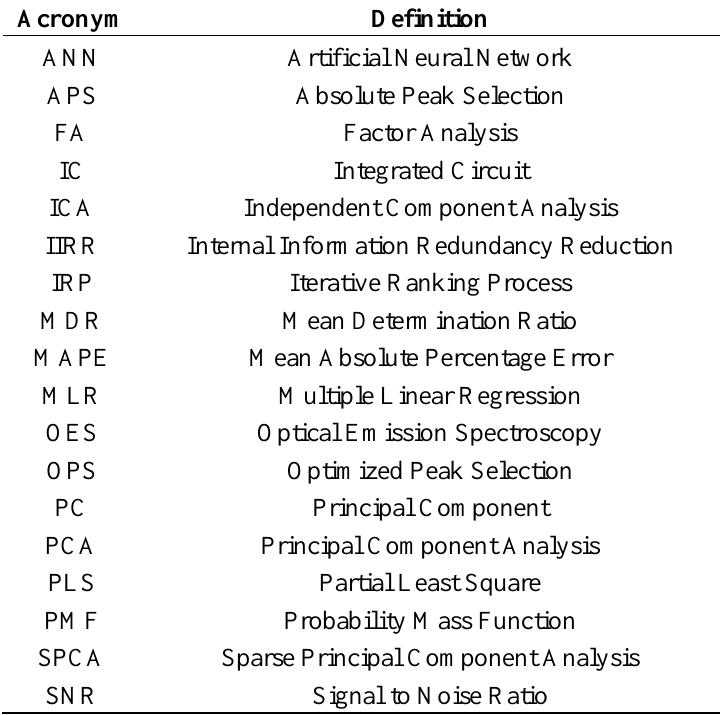
Table 1. Acronym